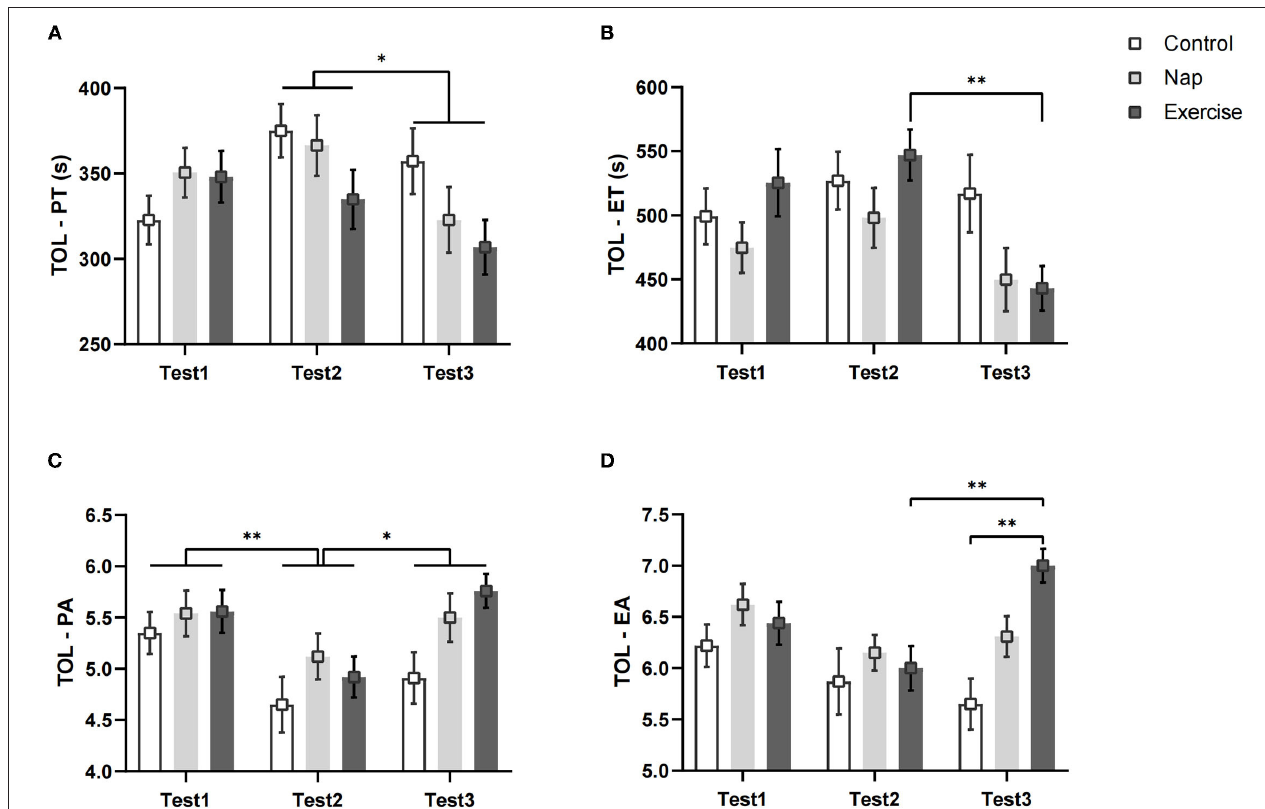
FIGURE 5 | TOL performance. (A) Planning time; (B) execution time; (C) planning accuracy; (D) execution accuracy. Error bars represent one standard error of the mean. ** p < 0.01, * p <